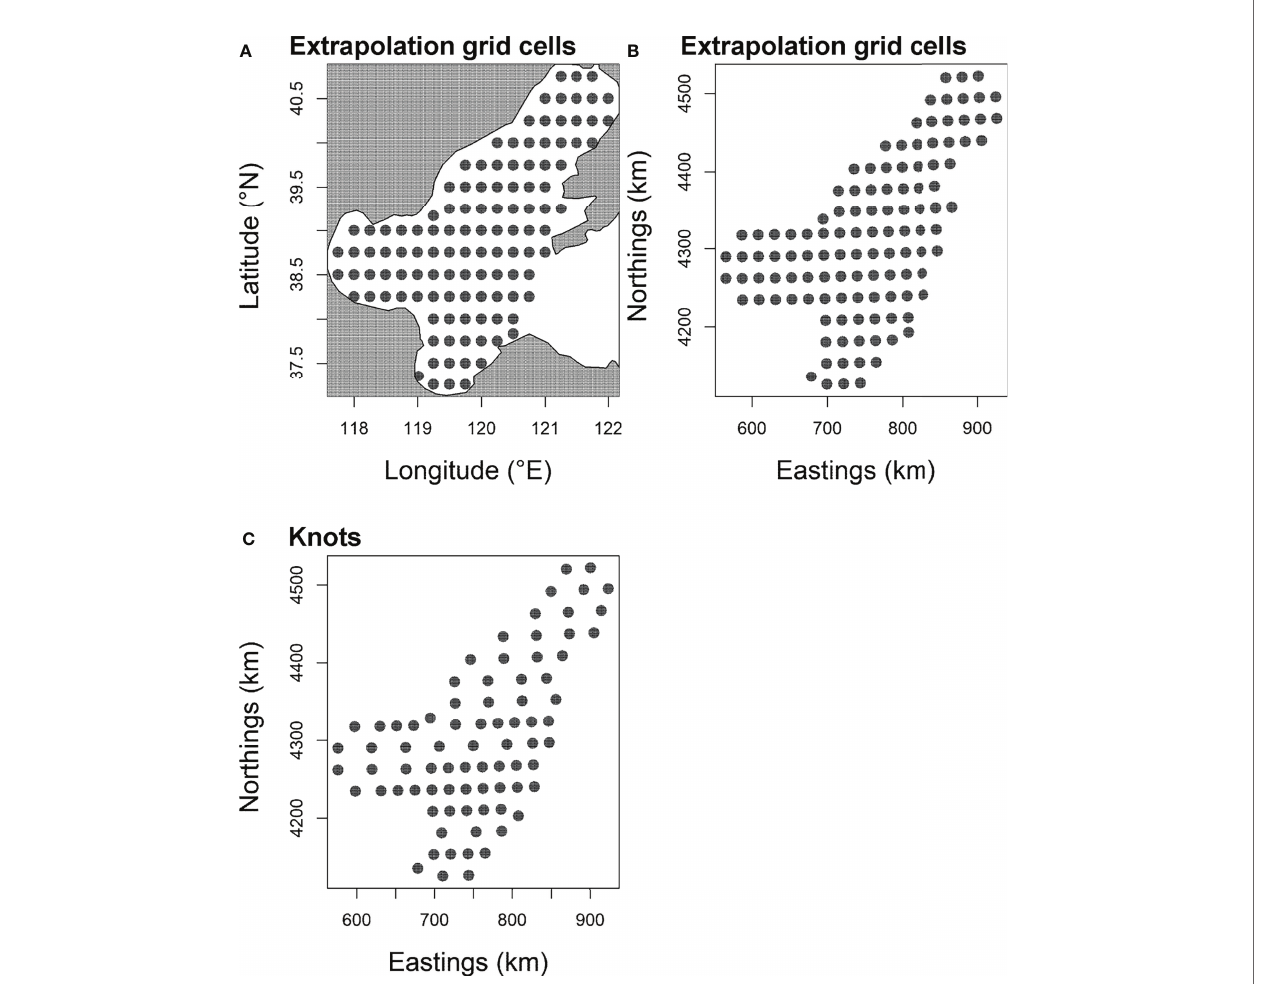
FIGURE 2 | The barycenter of 116 extrapolation grid cells (15× 15 arc-minutes) and of “ knots ” of the Bohai Sea in the present study. This barycenters of grid are depicted in (A, B) . To improve computational ef fi ciency, 100 “ knots ” (C) were assigned to approximate the spatial and spatio-temporal variation components of the model developed for the present